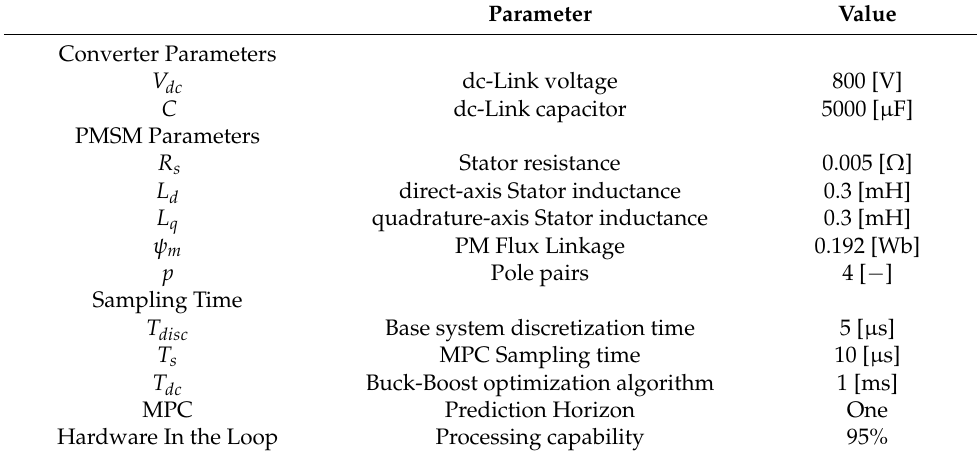
Table 3. Parameter used for the